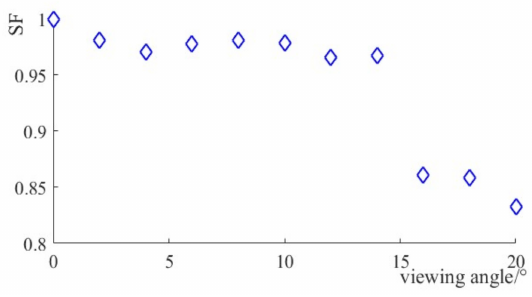
Figure 4. Similar factors at different viewing angles in